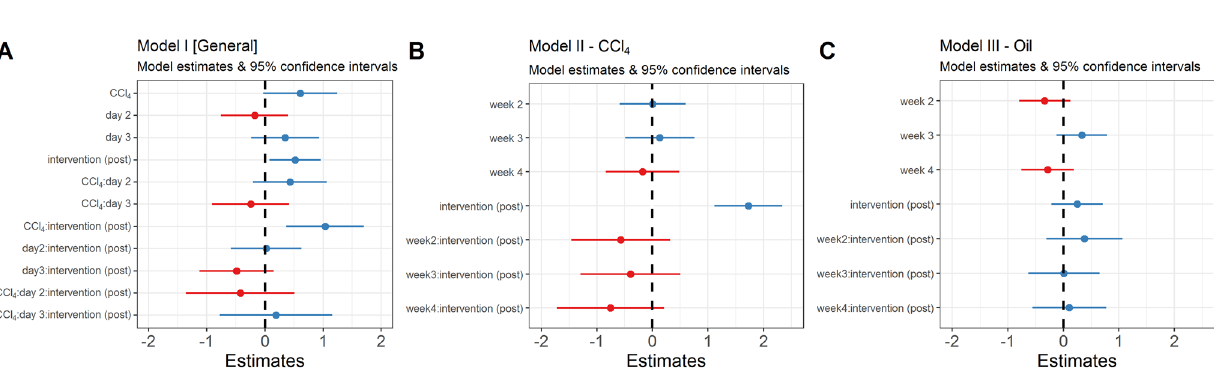
than Oil-pre-intervention. In model I, “day” or its interactions with “treatment” or “intervention” did not show significant differences (Fig. 3A). Model II: orbital tightening within‑CCl analysis. The analysis in model II focused on CCl 4 4 data (Sup- plemental Material S2, S4). Here, the within-treatment development of severity over time was modeled. There- fore, baseline data (at week 0) with missing interventions were excluded. As a result, this model’s default level of “week” was 1. Baseline level comparisons are shown in model I. Orbital tightening was modeled as a function